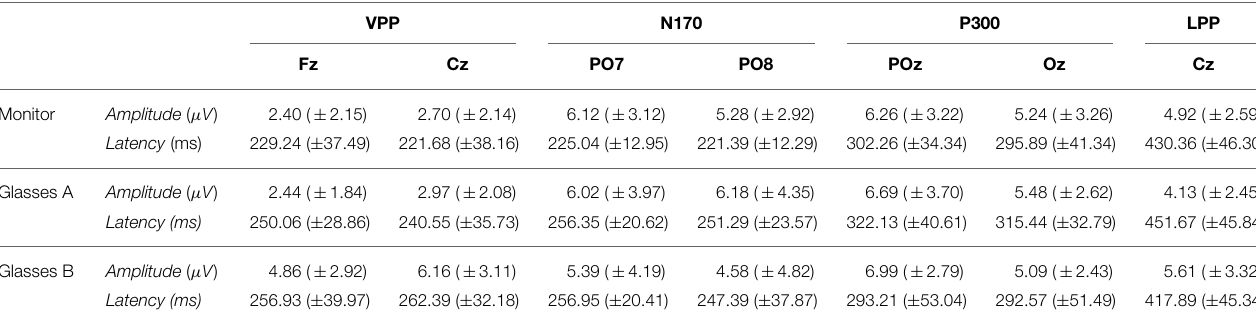
TABLE 2 | Mean amplitude and latency values and standard deviations for the VPP, N170, and P300 components at selected electrode positions. VPP N170 P300 LPP